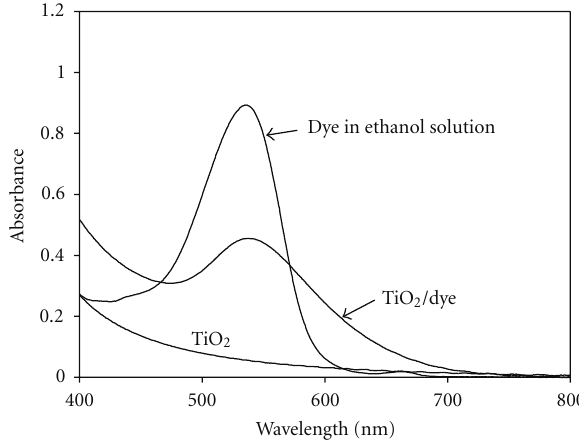
Figure 1: The absorption spectra of TiO 2 electrode, anthocyanin solution from black rice, and anthocyanin adsorbed onto TiO 2